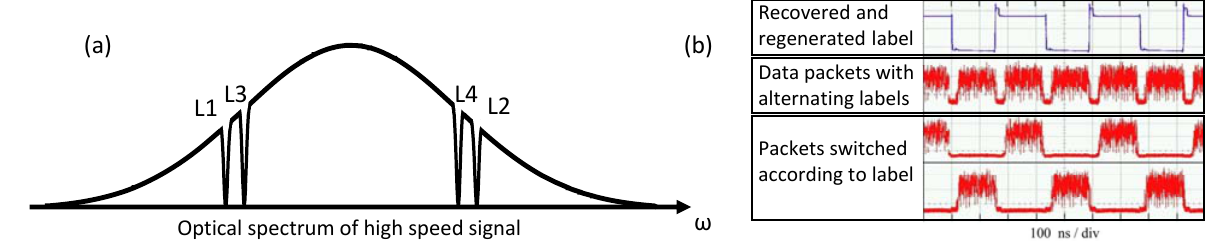
Figure 1. ( a ) Labeling of high speed data signals by spectral carving. L1–L4 indicate labeling positions where the presence or absence of power is interpreted as a digital